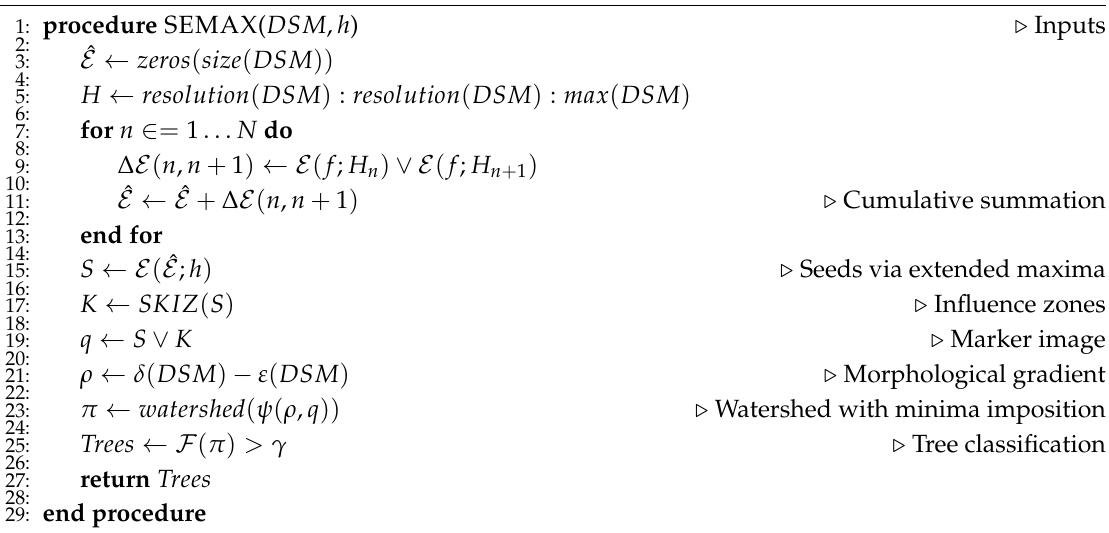
Algorithm 1 Proposed SEMAX algorithm for individual tree